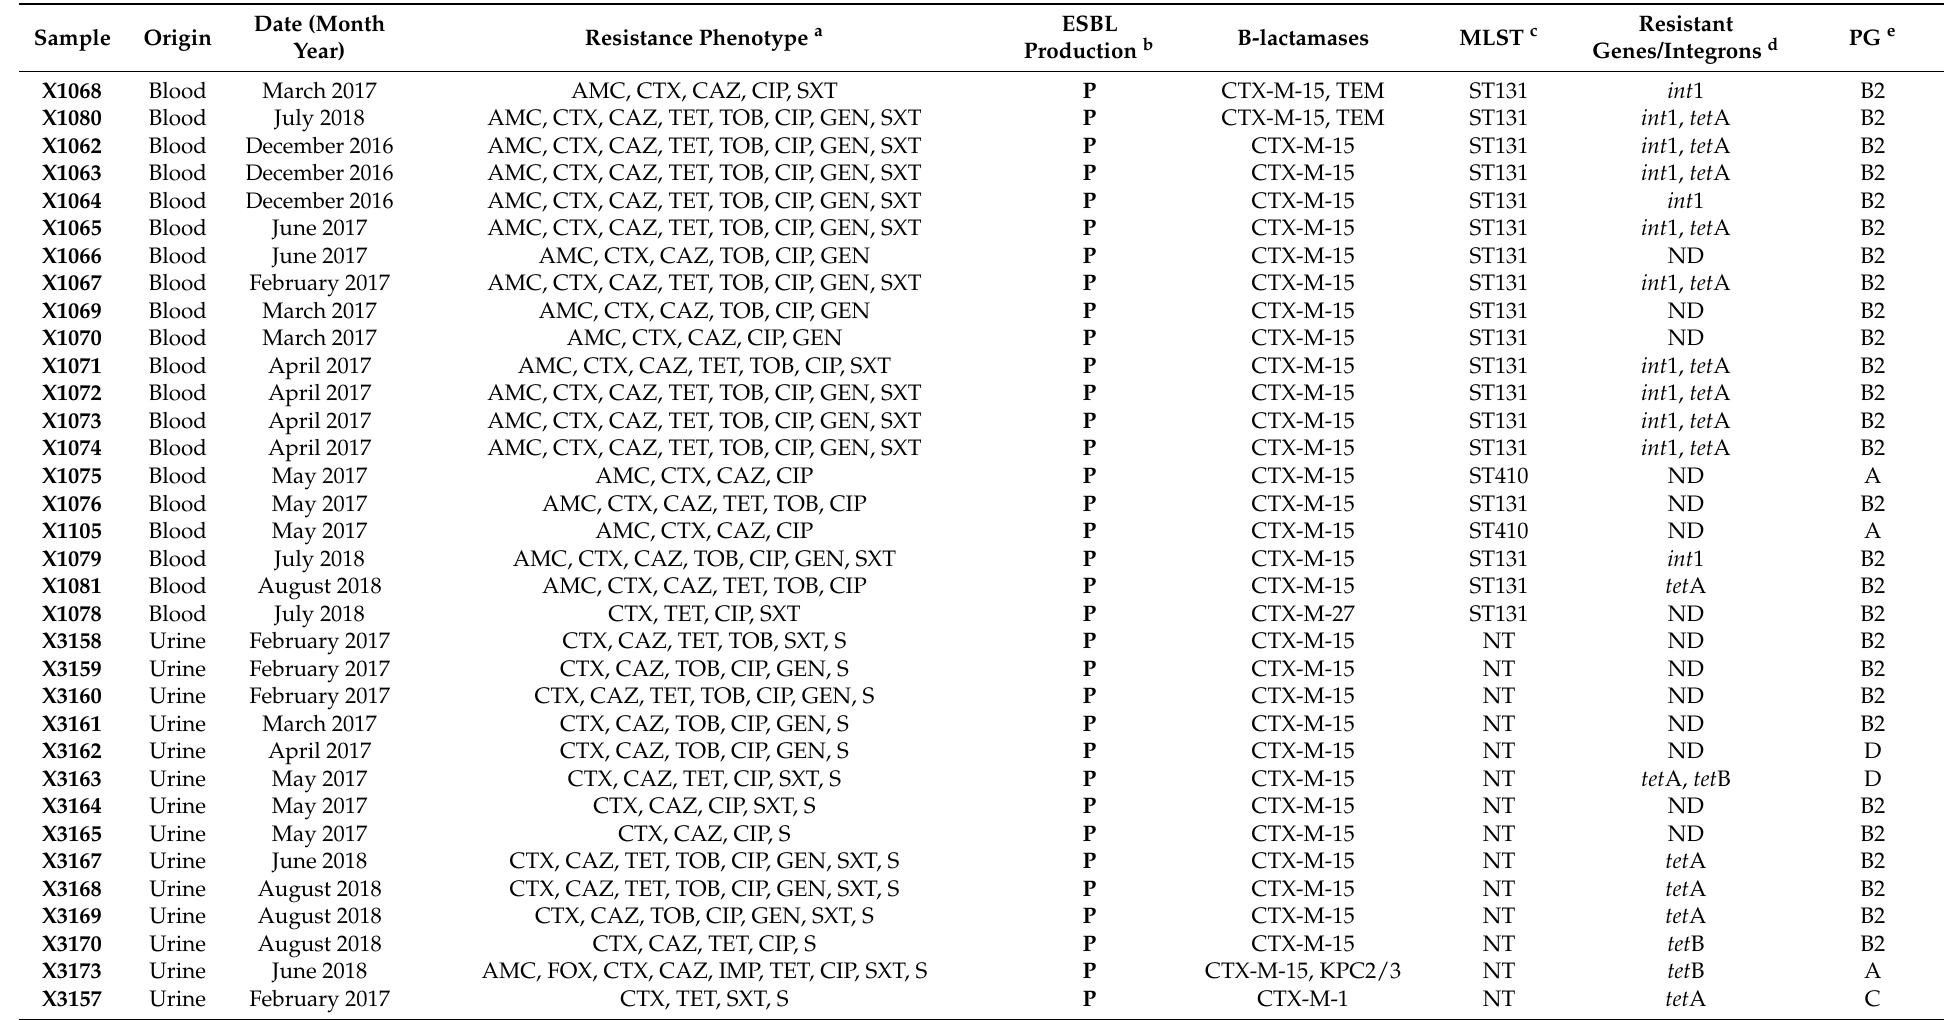
Table 1. Resistance phenotype and genotype in the 38 CTX/CAZ R Escherichia coli isolates from clinical samples in a Portuguese